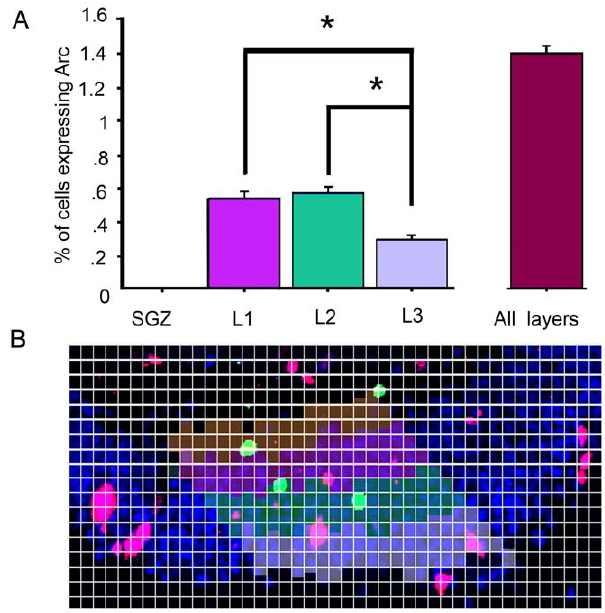
Figure 7. Dentate gyrus layer segmentation and Arc expression in the different layers. A) Shows a representative DG layer image segmented into 4 equidistant layers. NeuN-positive granular cells are shown in blue, Arc-expressing cells in pink, and BrdU-positive cells in green. The grid was used as a guide for the segmentation procedure, and the cells that were mainly ( . 50%) located in grids from a particular layer were considered to belong to that layer. The segmentation is represented by an overlay of translucent colors. In brown is the SGZ, in purple L1, in green L2, and in gray L3. B) Percentage of granular cells (from the general population) expressing Arc in the different DG layers after spatial exploration. The red bar is the proportion of cells expressing Arc in all